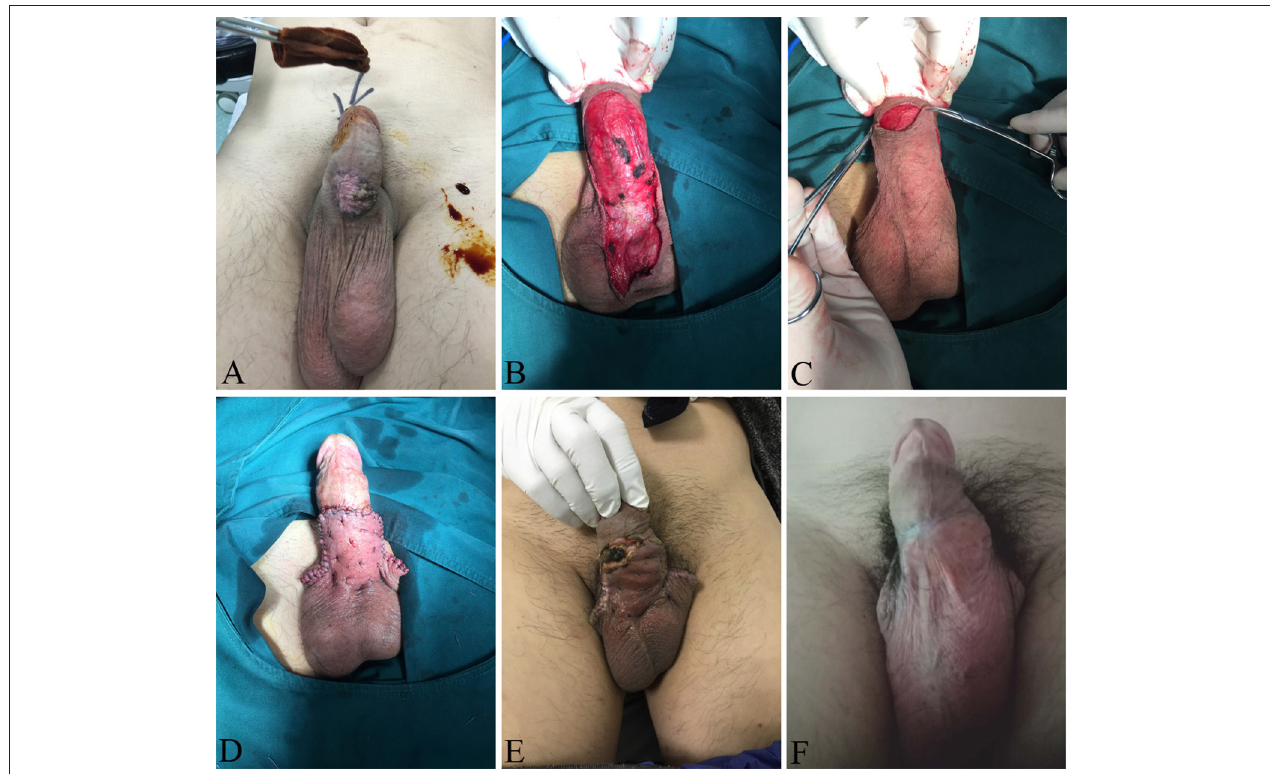
FIGURE 1 | Intraepithelial neoplasia lesion located on the ventral side of the penis (A) . Complete resection of the lesion tissue on the surface of the penile deep fascia (B) . The penile surgical area was covered with a pedicled scrotal flap (C) . The shape of the penis after lesion resection and plastic surgery (D) . The surgical area of the penis of the patient is not completely healed half a month after the operation (E) . Penile morphology after complete wound healing (F)